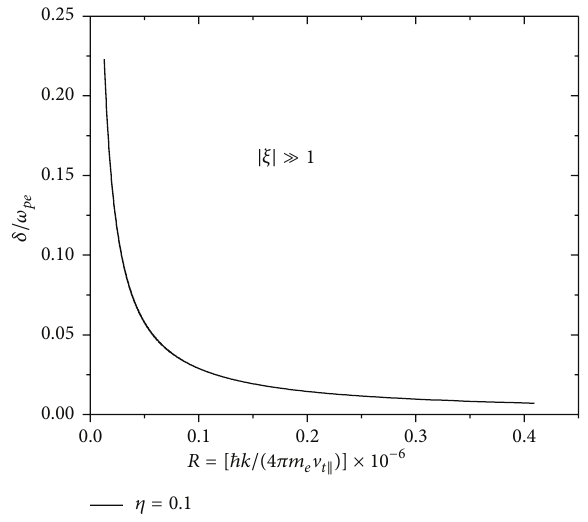
Figure 1: The normalized growth rate of the Weibel instability, 𝛿/𝜔 𝑝𝑒 , as a function of quantum parameter 𝜂 = 0.1 , and the large